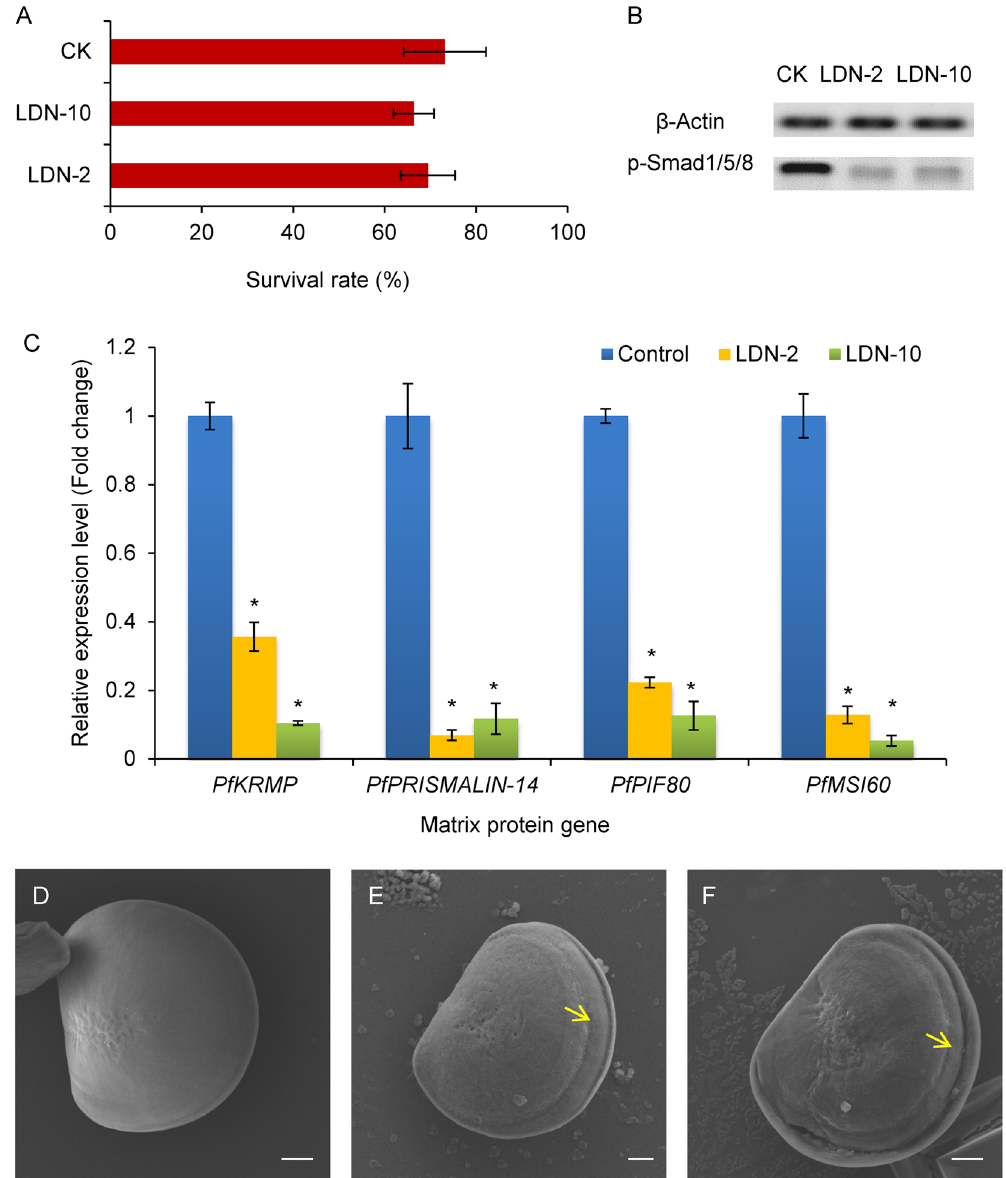
Figure 10. Effects of LDN193189 on shell germination during larval development in Pinctada fucata . ( A ) Survival rates of larvae exposed to different concentrations of LDN193189. CK: The Control larvae incubated in normal seawater. LDN-2: The larvae exposed to seawater with 2 μ M of LDN193189 for 48 h. LDN-10: The larvae exposed to seawater with 10 μ M of LDN193189 for 48 h. ( B ) Western blot analysis of the phosphorylation level of Smad1/5/8 in the larvae exposed to 2 μ M and 10 μ M LDN193189. p-Smad1/5/8: Phosphorylated Smad1/5/8. ( C ) The relative expression levels of MP genes in the larvae exposed to LDN193189. The expression levels of MP genes in unexposed larvae were used as corresponding controls. * P < 0.05. Differences were assessed by one-way ANOVA. (D-F) Scanning electron microscope (SEM) images of the shell surface of D-shaped larvae (Prodissoconch I) incubated in control ( D ), and 2 μ M ( E ) and 10 μ M ( F ) LDN193189. The yellow arrows indicate the wrinkled shell. Bar = 20 μ